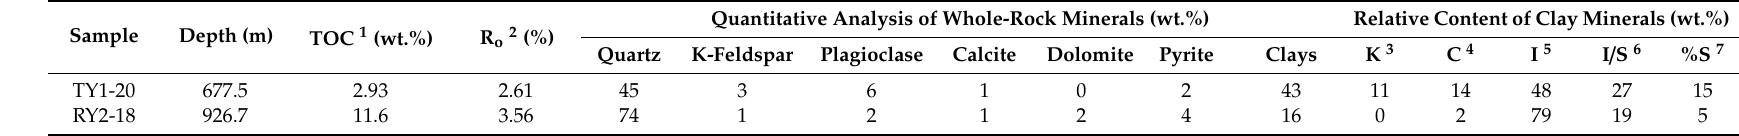
Table 1. Basic properties of shale samples used in this